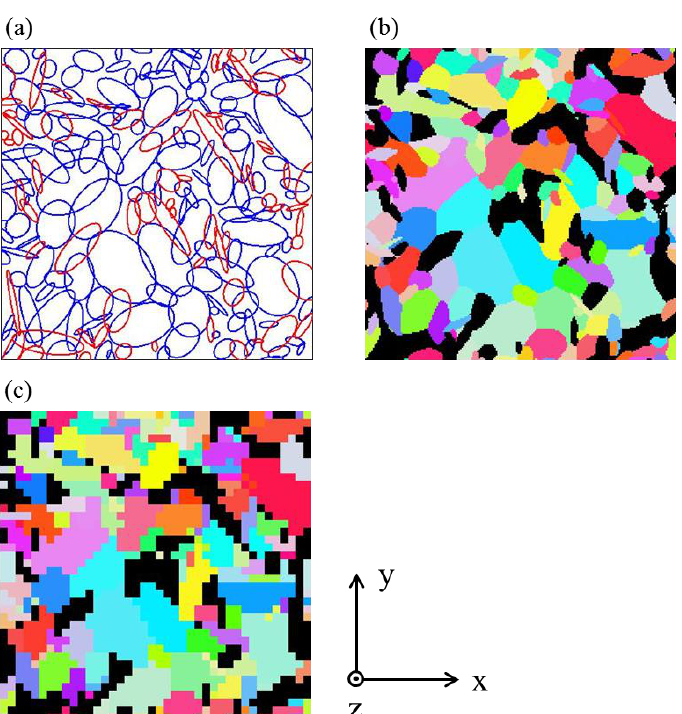
Figure 6. ( a ) Final configuration of the ellipse fitting process, ( b ) results of the anisotropic tessellation, and ( c ) finite element model.